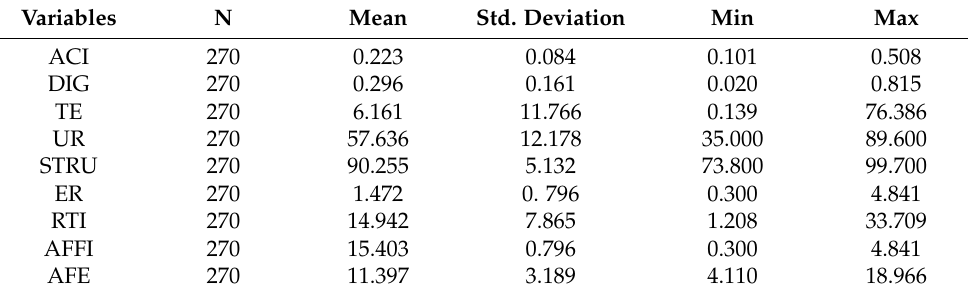
Table 4. Descriptive statistics for the